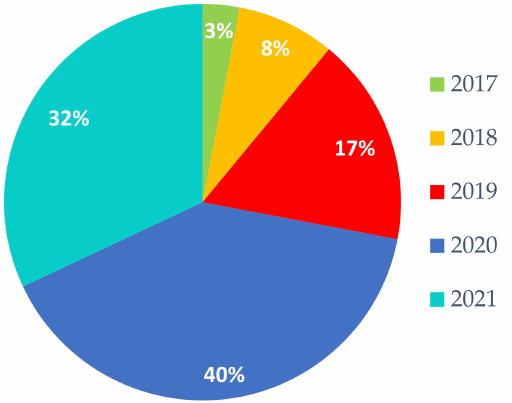
Figure 23. Percent of research papers per year with the highest impact for the new trends in Me detection by